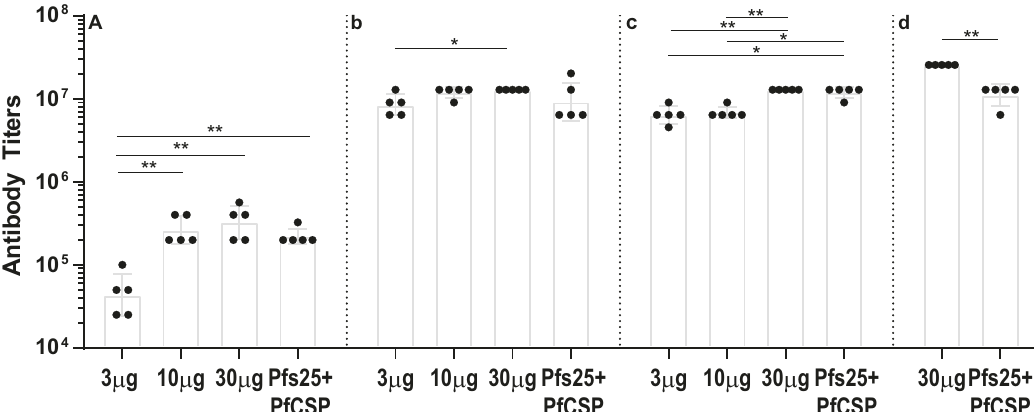
Fig. 2 Pfs25-speci fi c antibody titers determined by ELISA. mRNA-LNP immunization and blood collection schedules are shown in Fig. 1a. Sera ( N = 5 per group) from bleeds at indicated time points [B1 in ( a ), B2 in ( b ), B3 in ( c ), and B4 in ( d )] were analyzed using ELISA to determine antigen-speci fi c antibody titers reported as the geometric mean endpoint titers with 95% con fi dence intervals. Endpoint titers were identi fi ed as the highest reciprocal serum dilution with an OD higher than a cutoff of the average OD plus three standard deviations of pre-immune sera replicates. Statistical analysis was performed using the Mann – Whitney U test (* p < 0.05; ** p < 0.01).